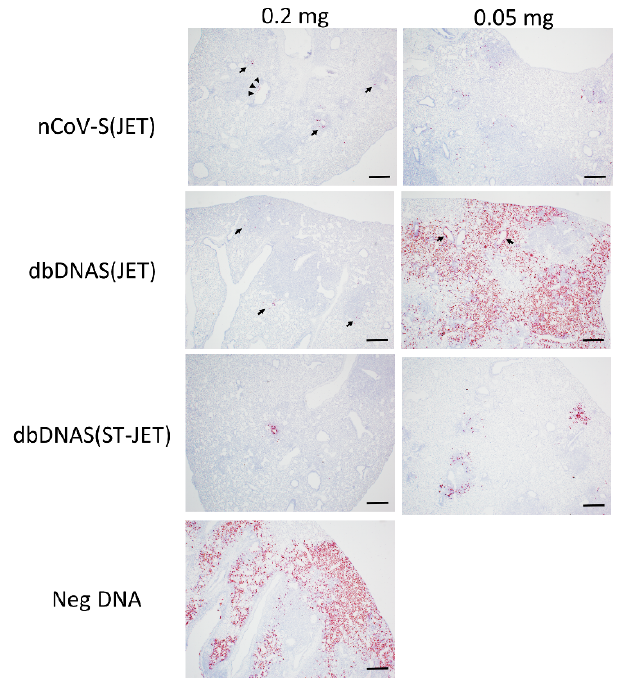
Figure 4. SARS-CoV-2 ISH labeling of FFPE lung tissues from DNA-vaccinated hamsters. Lung sections from 0.2 and 0.05 mg DNA-vaccinated hamsters show SARS-CoV-2 genomic RNA in red. Arrows in nCoV-S(JET) and dbDNAS(JET) 0.2 mg images indicate rare positive labeling within the section, and arrowheads indicate labeling of intraluminal bronchiolar cellular debris. Arrows in dbDNAS 0.05 mg indicate multifocal dense positive labeling within areas of inflammation and bronchiolar epithelium. Scale bars = 400 microns.